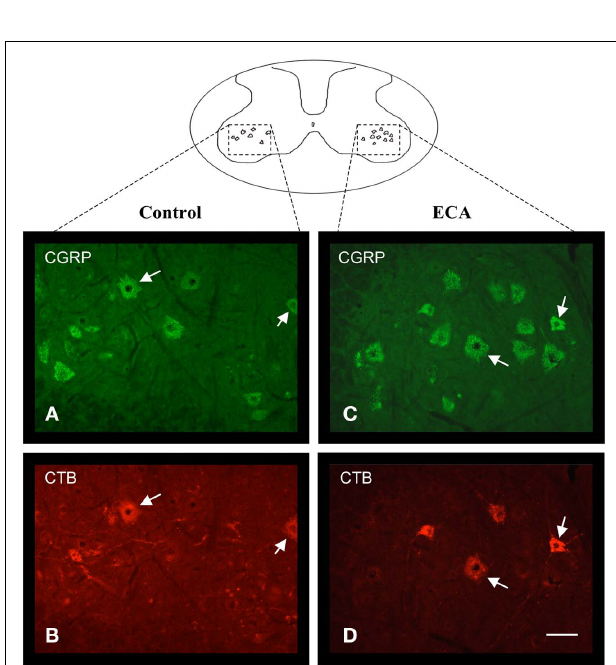
FIGURE 2 |Transverse L5 spinal cord sections 6months after transection and repair of the left rat sciatic nerve with ECA, double-labeled with anti-CGRP (A,C) and anti-CTB (B,D). Two images, each with appropriate filter, were captured from identical visual fields. Note that all CTB-labeled α -motoneurons also demonstrate CGRP-positive labeling (arrows). Nor was any difference between repair and controls regarding shape, fluorescence intensity, or neurite appearance seen. Scale bar = 50 μ